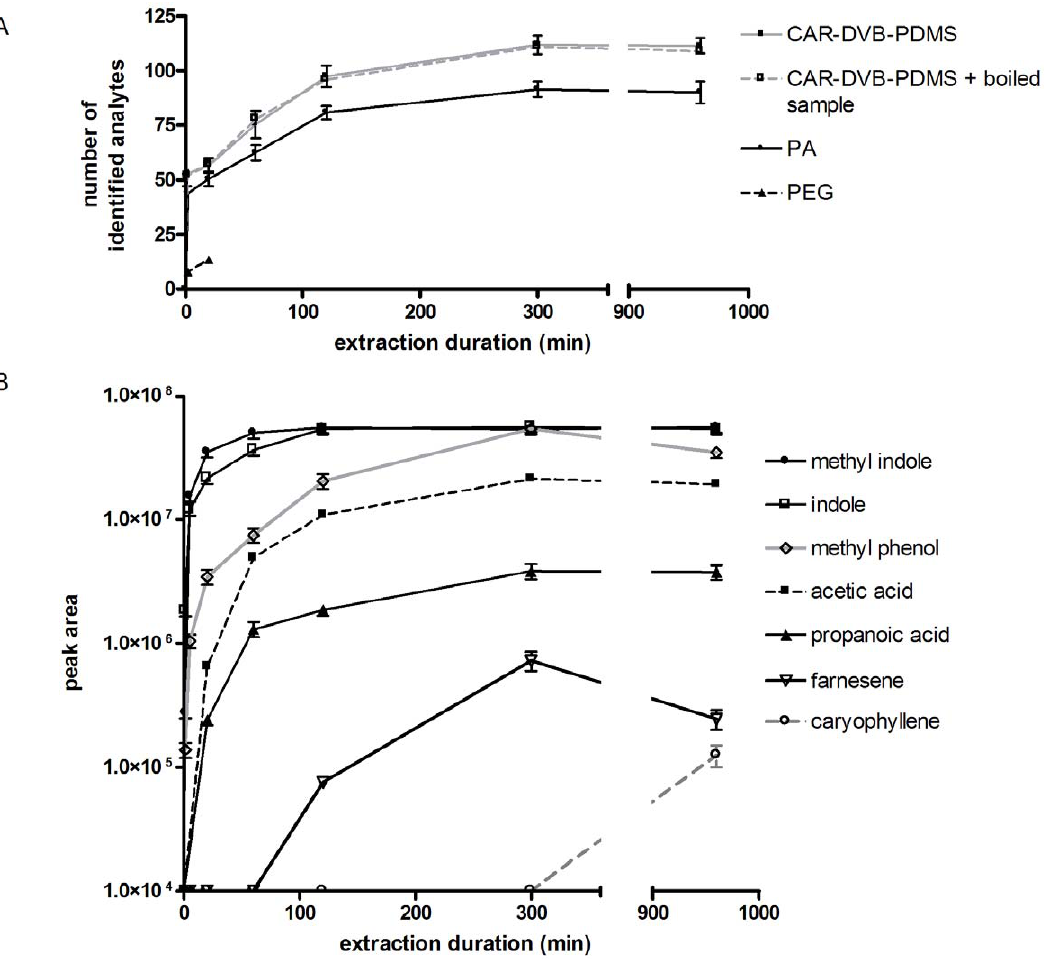
Figure 1. Extraction duration and headspace SPME of human feces. A) A plot of identified analytes as a function of extraction time. Nonlinear regression fitting the hyperbolic extraction curve yields a Y max of 114 + / 2 3 for the CAR-DVB-PDMS fiber (R 2 =0.9937) and 94 + / 2 4 for the PA fiber (R 2 =0.9791). The PEG plot could not be extended beyond 20 min due to an unknown analyte overwhelming the MS detector. Also shown in this plot is the number of identified analytes obtained from a sample that was pretreated by boiling for 5 min before extraction. Essentially no difference in analyte number or composition is observed with the pretreated sample (CAR-DVB-PDMS + boiled sample) relative to an untreated sample (CAR-DVB-PDMS). All samples were analyzed in duplicate. See text for further discussion. B) A plot of area under the chromatographic curve as a function of time for the indicated analytes obtained using the CAR-DVB-PDMS fiber. Differences in extraction rates for the indicated metabolites are apparent.